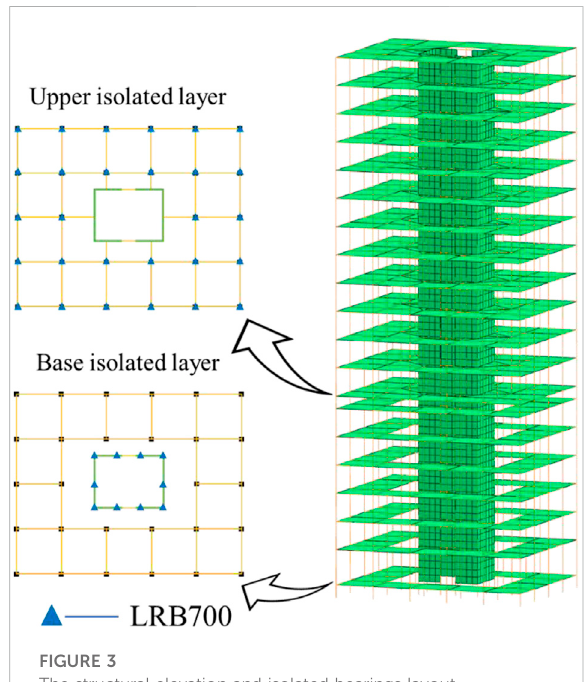
The structural elevation and isolated bearings